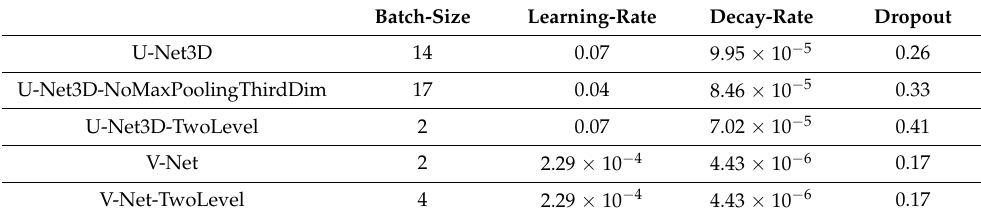
Table 1. Hyperparameters setting for each network using Optuna.